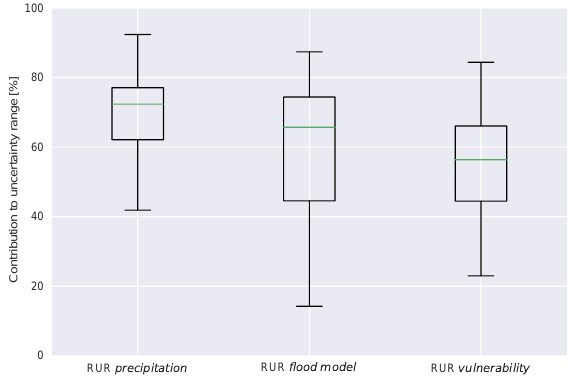
Figure 7. Reduced uncertainty ranges RUR of the subsets of model runs representing the three main uncertainty